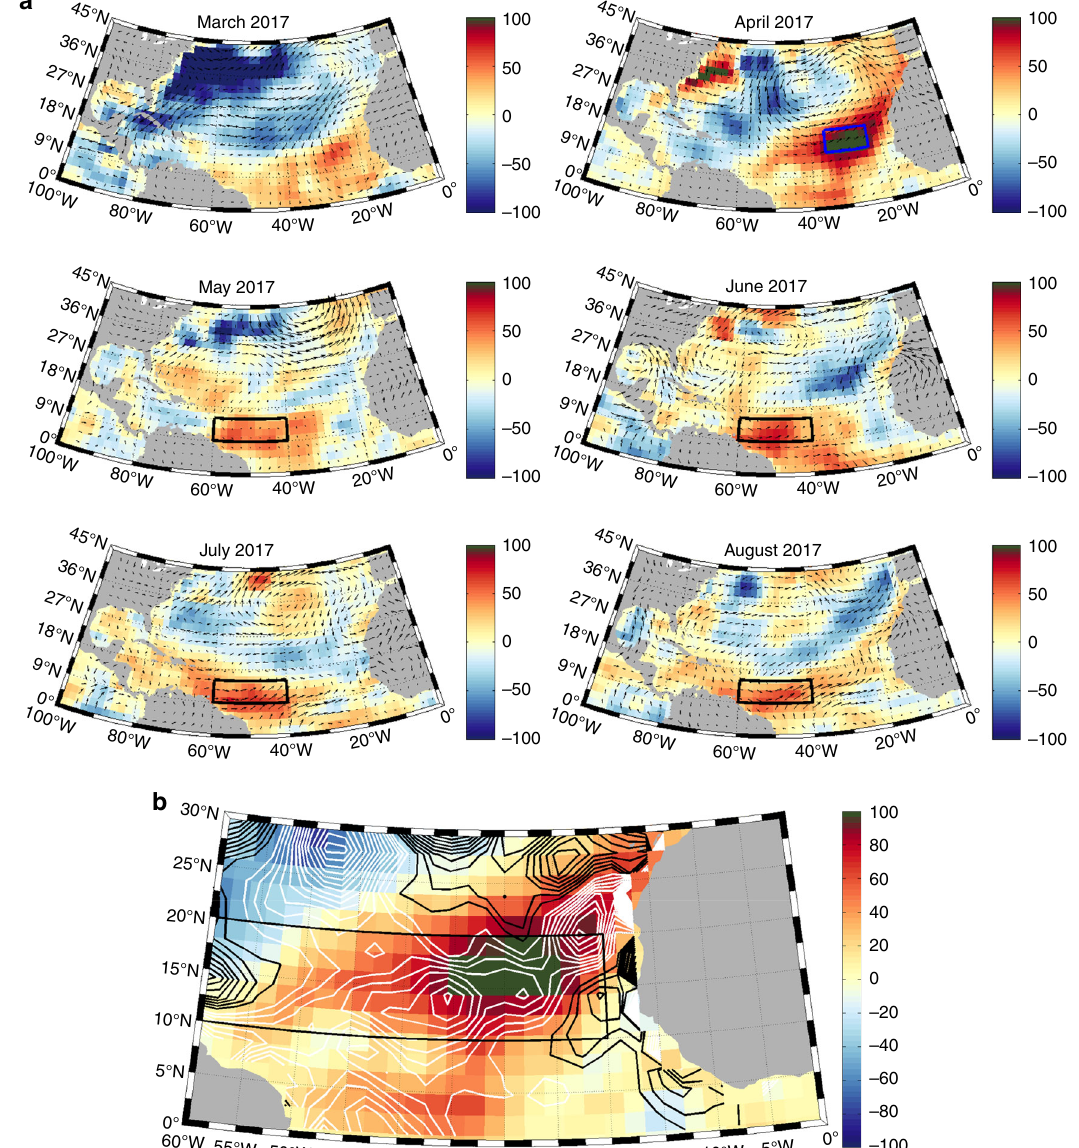
Fig. 4 Atlantic Surface Heat Flux Anomalies (the sum of the net shortwave, net longwave, latent and sensible heat fl uxes) during the build-up and early stages of the 2017 hurricane season. a Observed monthly surface heat fl ux anomaly from March to August 2017 (Wm − 2 ) overlaid with the 1000 mb wind anomaly, red colours indicate stronger heat gain than normal. Blue box indicates the eastern Atlantic region. Black box indicates the southern MDR region. b Observed Atlantic surface heat fl ux anomaly in April 2017 (Wm – 2 ) overlaid with the wind stress curl anomaly (WSCA). White contours indicate a negative WSCA (anomalous downwelling), grey contours indicate a positive or zero WSCA (anomalous upwelling). Contour units are 10 − 8 Nm −